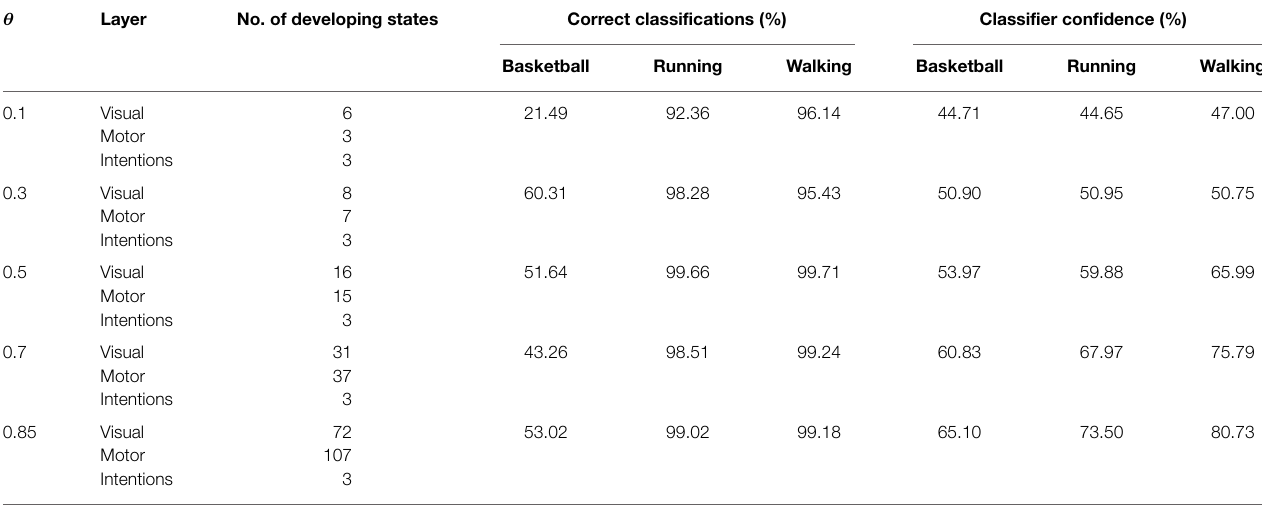
TABLE1 | Overviewofthenumberofdevelopingstatesduringlearningindependencyon (cid:18) andtheresultingclassificationperformancesduringobservation of movements not seen during training